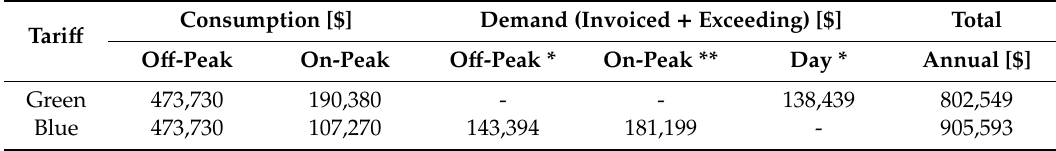
Table 6. Main results for Scenario 2.